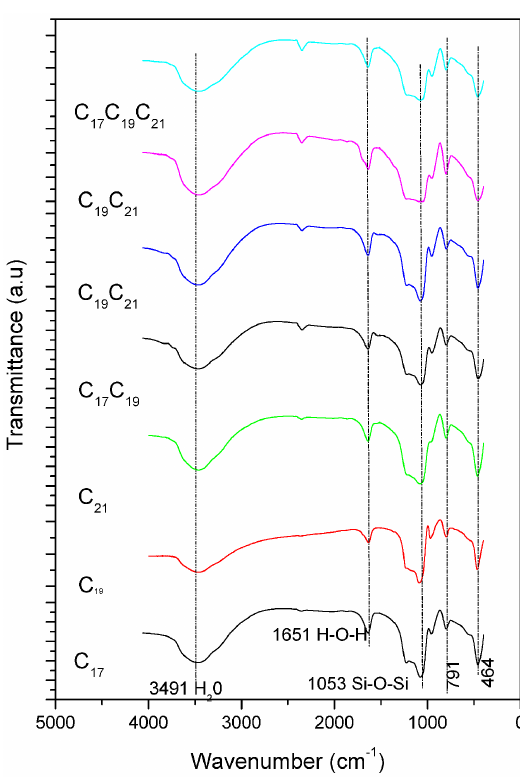
Figure 5. FTIR from calcined samples C C C and C 19 21